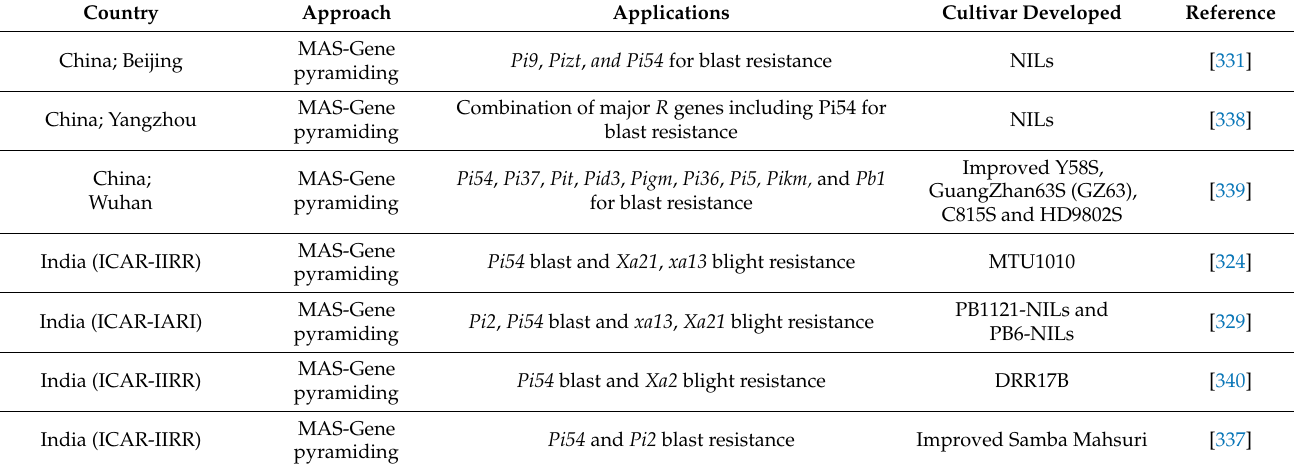
Table 6. Applications of Pi54 gene in developing blast resistance